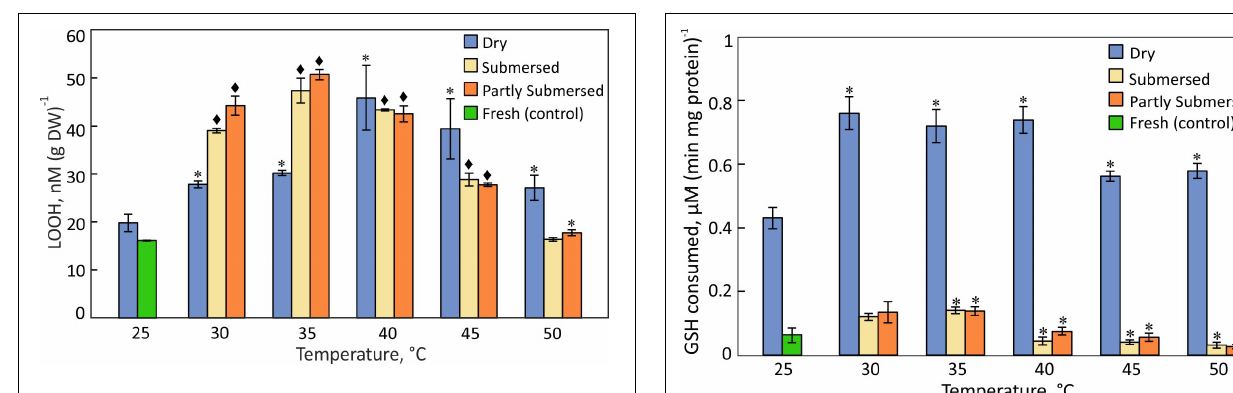
FIGURE 8 | Lipid hydroperoxide (LOOH) content in dried and fully or partly submersed Pleopeltis fronds exposed to different temperatures for 24 h. The content from heat treated dry and hydrated fronds is compared with 25 ◦ C dry and fresh (control), respectively. Significant differences between treated and controls are indicated by * ( P ≤ 0.05) and (cid:7) ( P ≤ 0.001); means ± SE, n = 4.